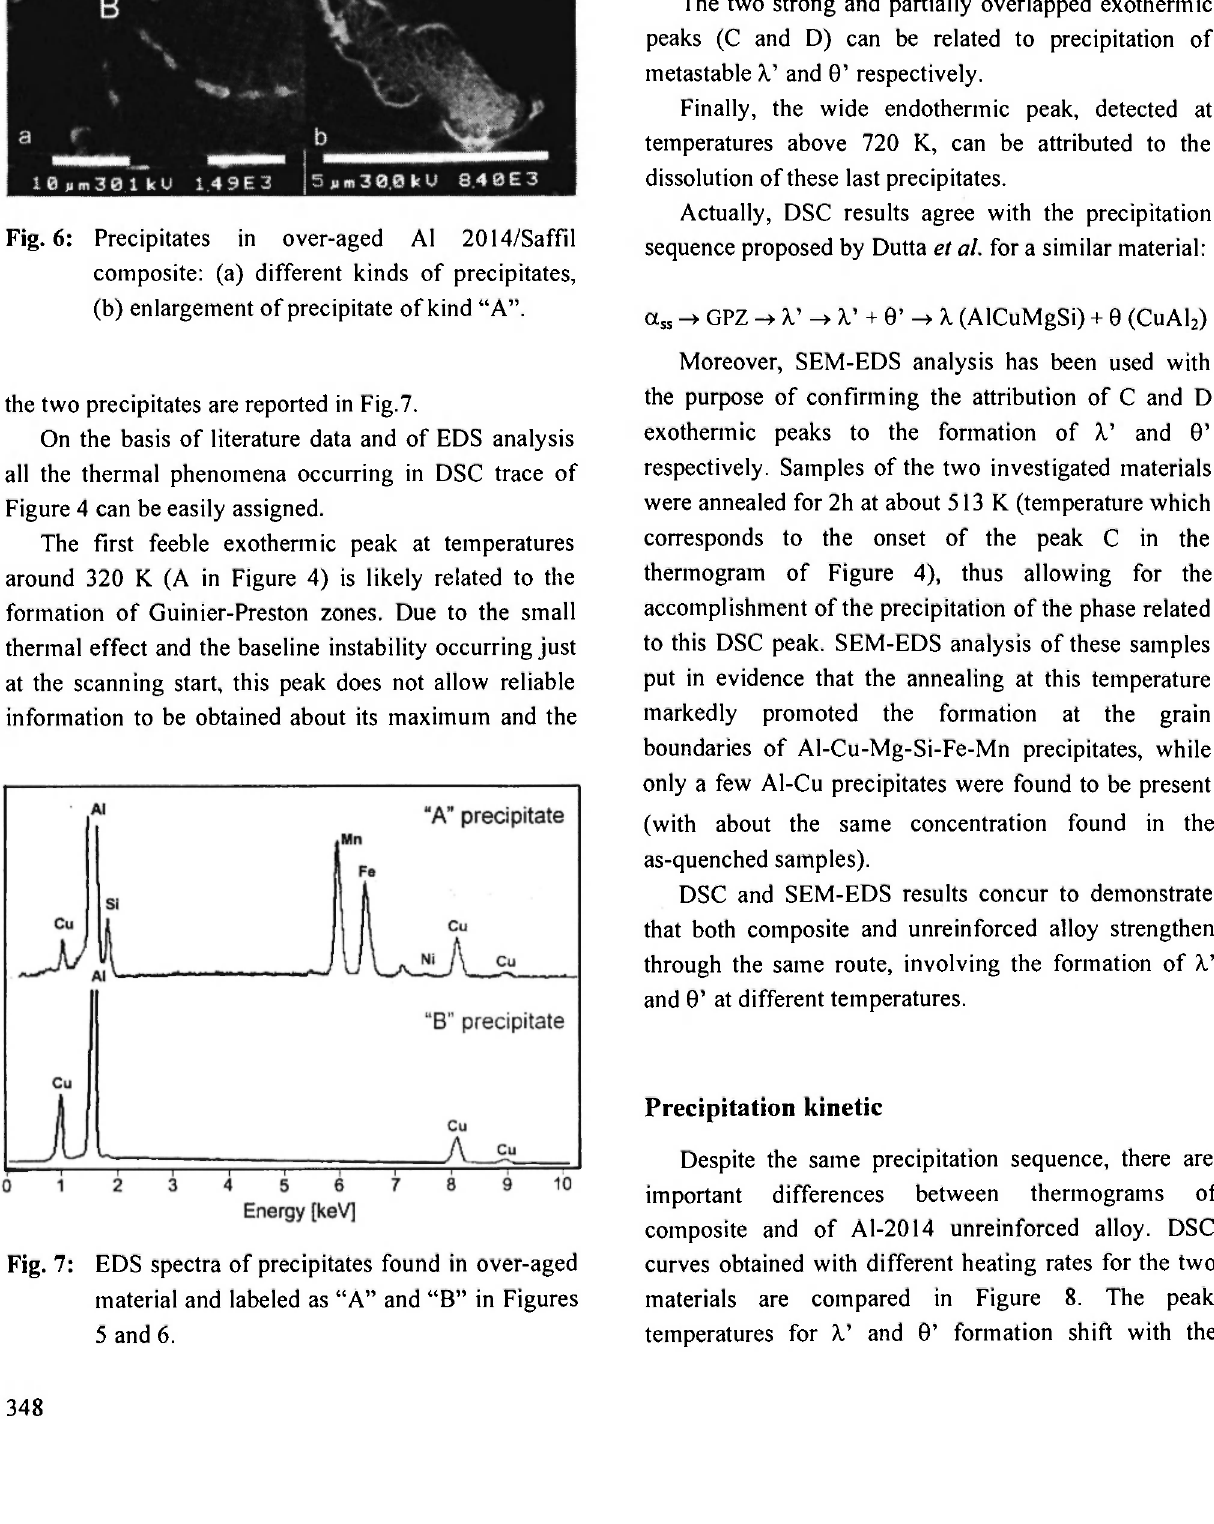
Fig. 7: EDS spectra of precipitates found in over-aged material and labeled as "A" and "B" in Figures 5 and